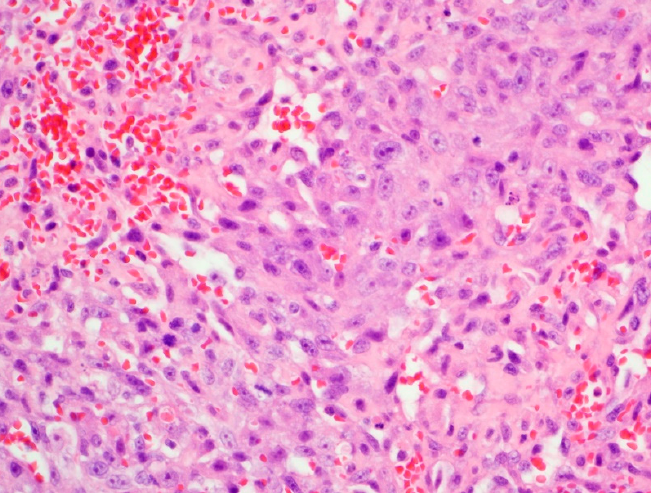
Figure 1. Histopathology of the pericardial mass.